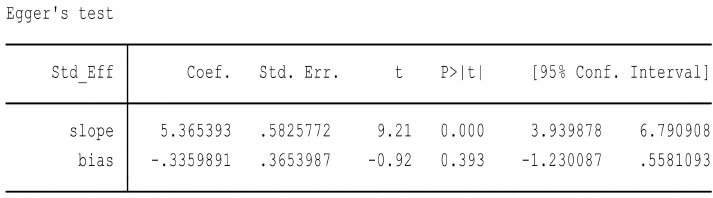
Figure 9. Eggers regression test to test hypothesis